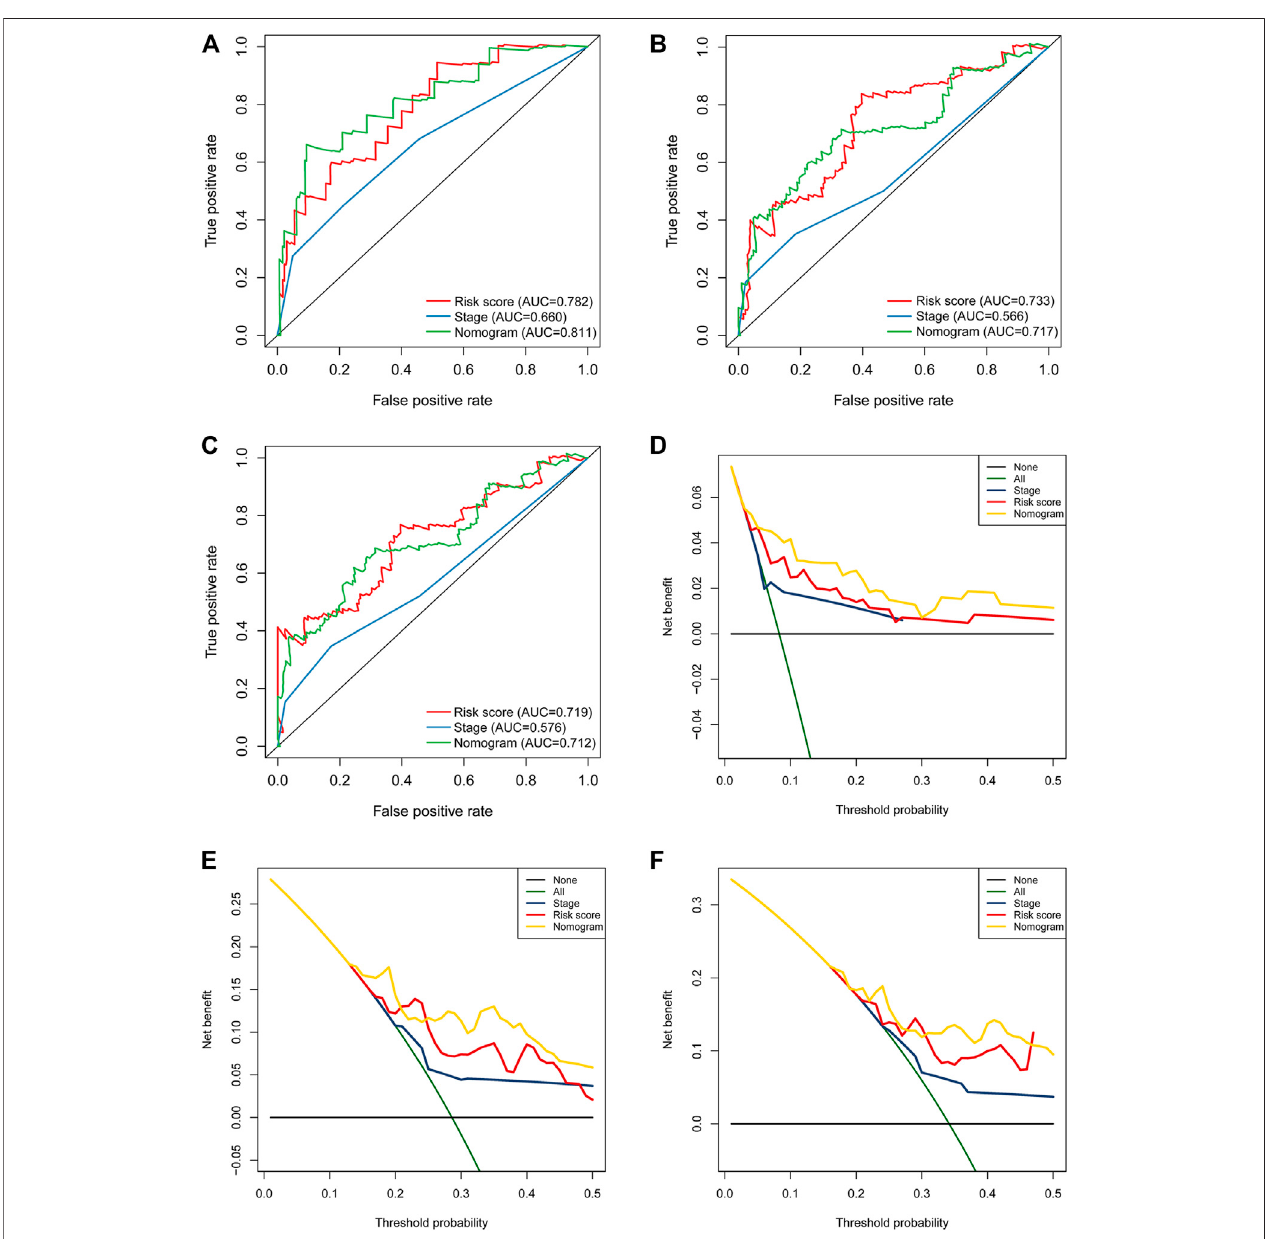
FIGURE 7 | The nomogram showed better predictive power than the 5-immune-gene signature and clinical stage for 1-year OS. Time-dependent ROC curves of the nomograms, 5-immune-gene signature, and clinical stage in prediction of (A) 1-year, (B) 3-years, and (C) 5-years OS for CSCC patients. DCA curves for the nomogram, 5-immune-gene signature, and clinical stage in prediction of (D) 1-year, (E) 3-years, and (F) 5-years OS for CSCC patients. DCA, decision curve analysis.